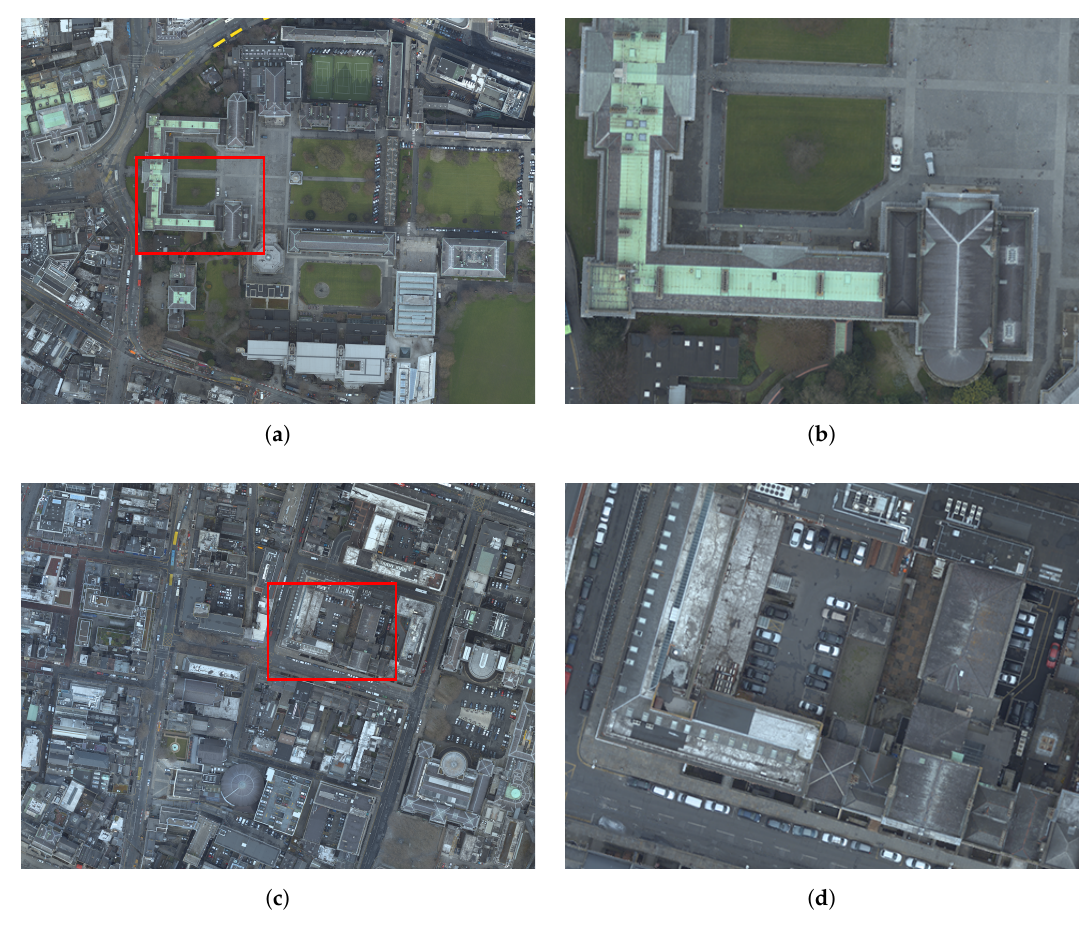
Figure 21. ( a ) True orthophoto for the Trinity College study area; ( b ) A closer look at the area enclosed by the red rectangle in part (a); ( c ) True orthophoto for the Dawson Street study area; and ( d ) A close-up of the area inside the red rectangle in part (c). Pixel size is equal to 10 cm in the orthophotos.